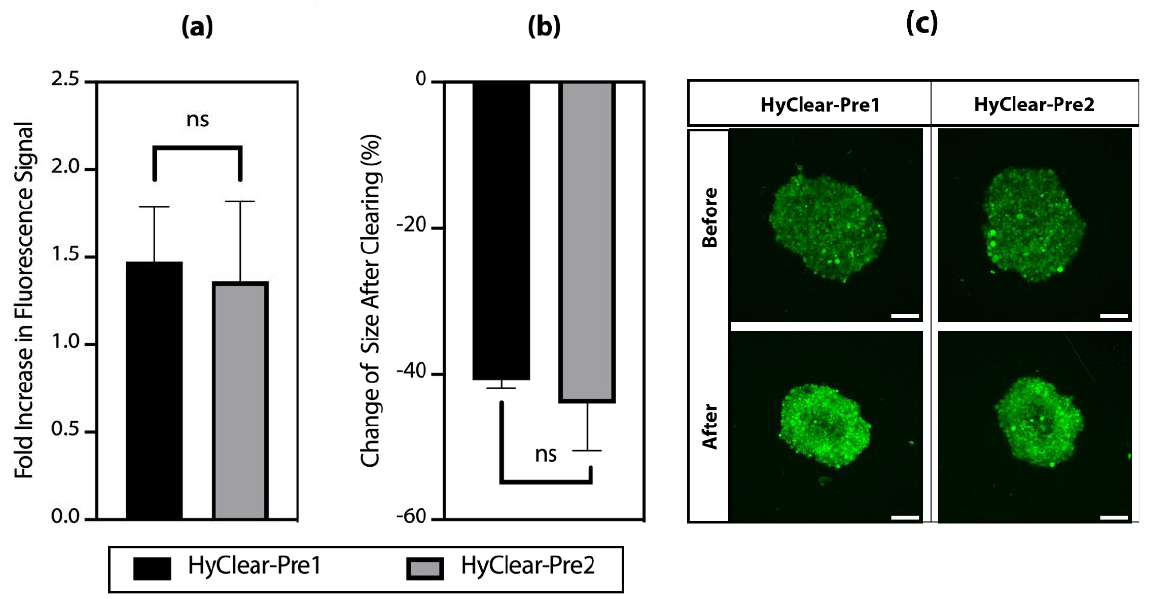
Figure 4. ( a ) The average fold increase in the fluorescence signal after clearing using different types of HPG. ( b ) The average change of the area of the cross ‐ sectional images before and after clearing using different types of HPG. ( c ) An example of the MIP image of the spheroids before and after tissue clearing using different types of HPG. The error bars represent the standard error of the mean of five to six replicates.